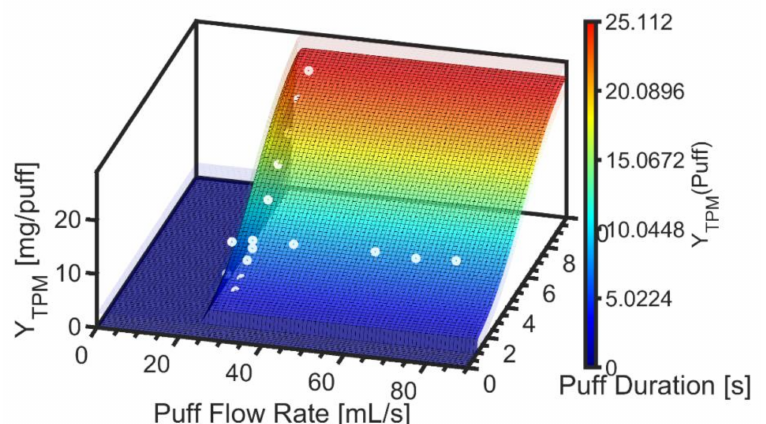
Figure 3. Product EC14-01. Screening emissions model for TPM yield per puff is illustrated as the colored surface plot, with semitransparent surfaces above and below the model surface to reflect the 95% confidence interval on the nonlinear regression. Underlying data are illustrated with markers.